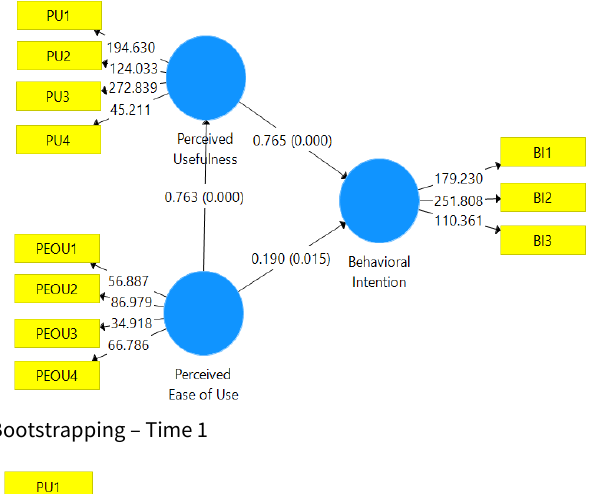
Figure 5. Results after running Bootstrapping – Time 1